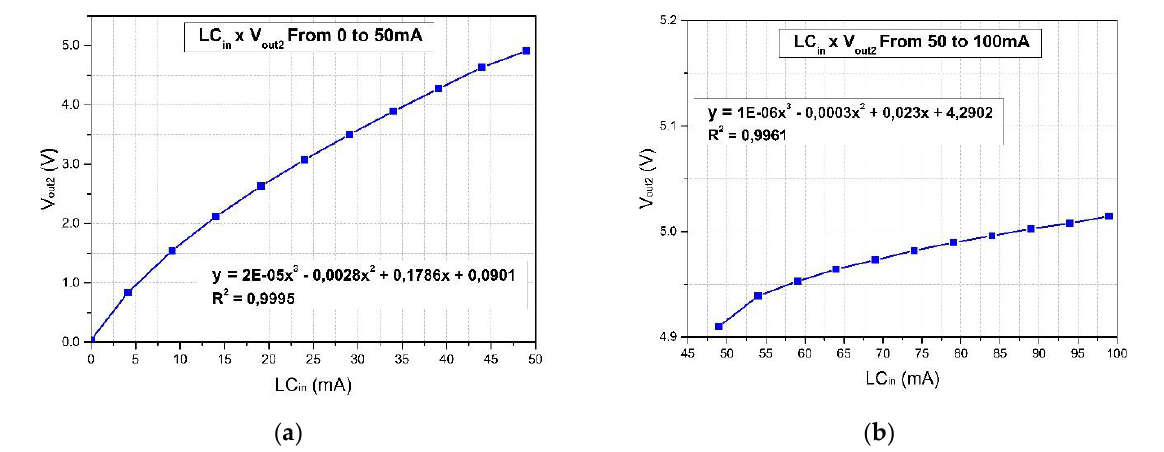
Figure 8. The calibration procedure of the sensor consists of the input of a current to the sensor and measurement of the output voltage at point V out2 (see Figure 1). ( a ) Calibration curve for an input range of between 0 and 50 mA; ( b ) calibration curve for an input range of between 50 and 100 mA.